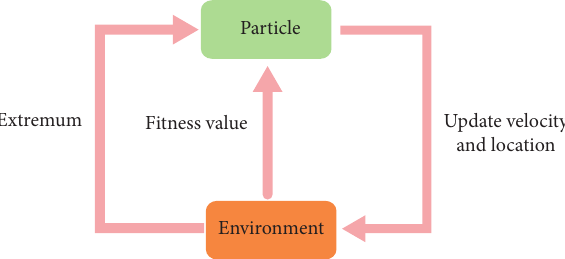
Figure 5: Application of reinforcement mechanism to